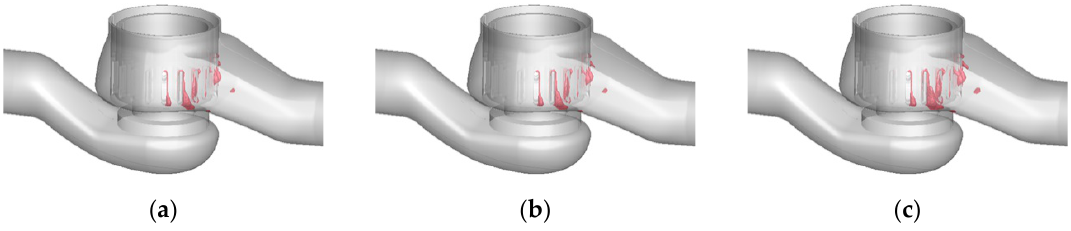
Figure 8. Water vapor volume distribution in two-cage globe valve with different working temperature: ( a ) 20 °C; ( b ) 40 °C; ( c ) 60 °C.